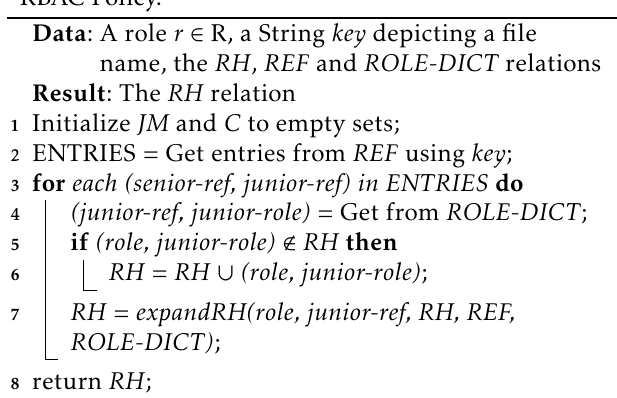
Algorithm expandRH : Constructing the RH of an RBAC